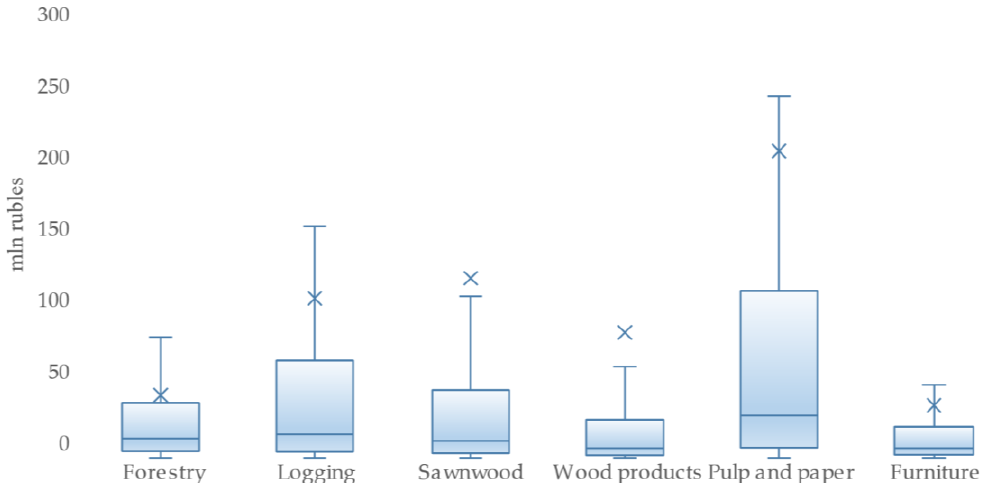
Figure 1. The revenue distributions for the Asian Russian forest companies by the economic activity type, mln rubles.